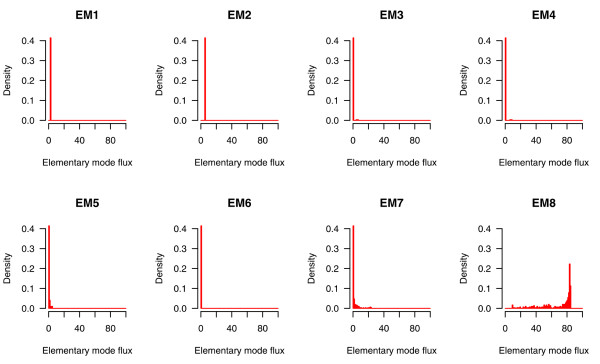
Elementary mode fluxes spanned by kinetic parameters. Distributions of elementary mode fluxes obtained for 400 random sets of values of all kinetic parameters in the system. Vertical axes have been cut at 0.4 but the height of peaks for constant modes extends till 1.